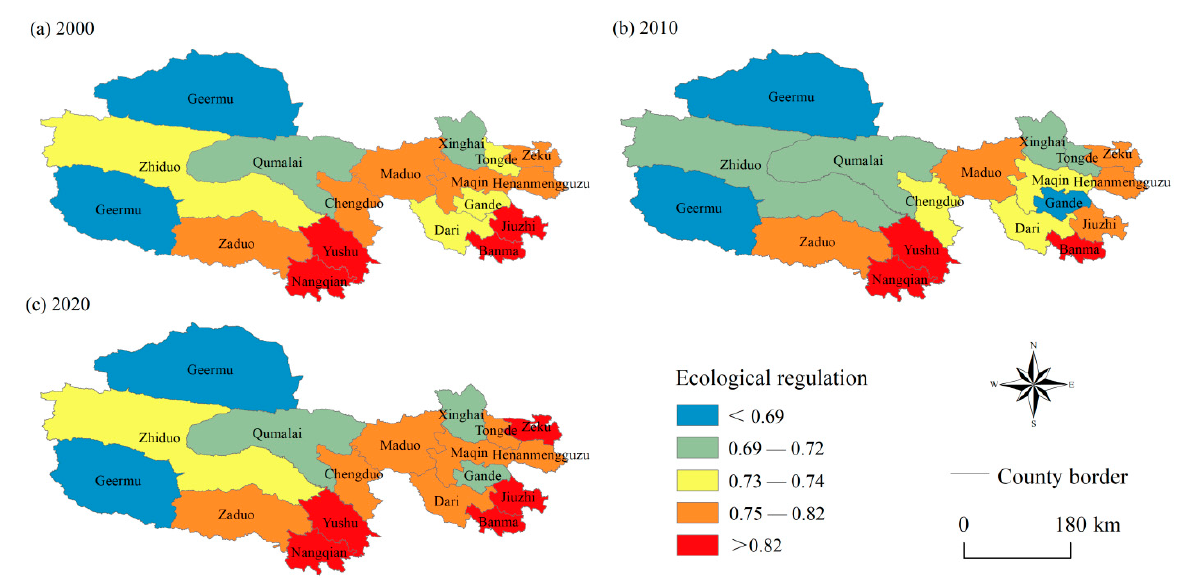
Figure 6. Spatiotemporal differences in the ecological regulation index (ERI) in the Sanjiangyuan area during 2000–2020.